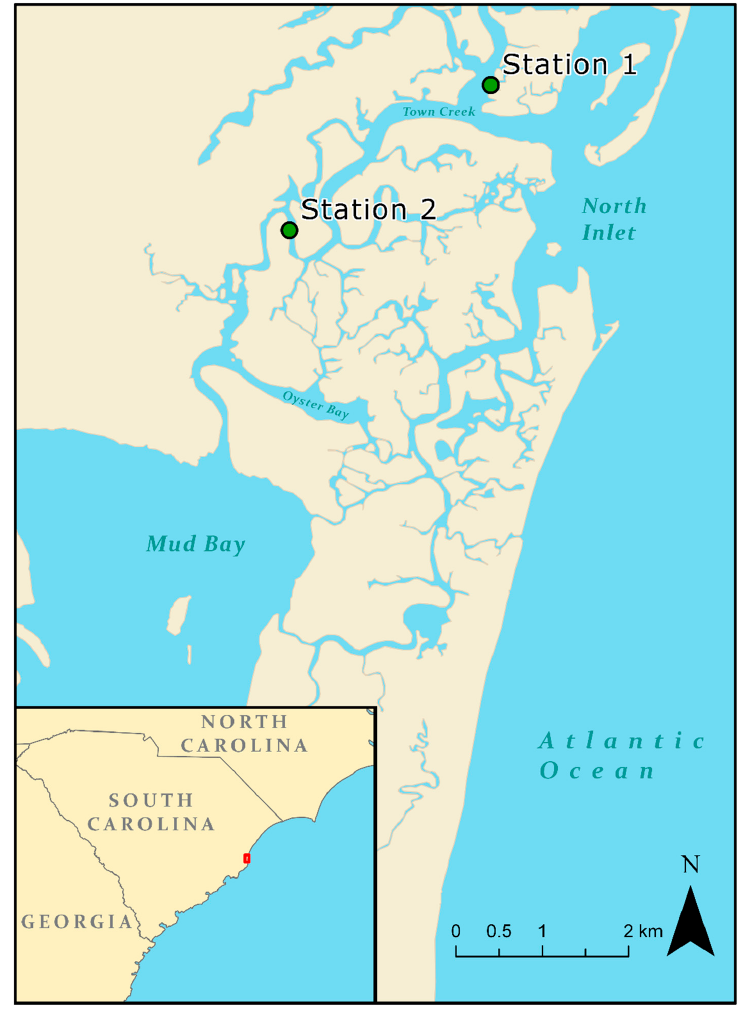
Figure 1. Study site in North Inlet Estuary, South Carolina, USA, showing regional coastline and deployment locations labeled Station 1 and Station 2. Station 1 is located closer to the inlet entrance near the confluence of Town Creek and Old Man Creek. Station 2 is located in the marsh interior, where the channel narrows. Station 1 is situated on a low relieve oyster bank and Station 2 is situated on a steeper mud bank. Both stations are backed by saltmarsh populated with the cordgrass Spartina alterniflora . The base of the marsh scarp coincides with the line delineating the S. alterniflora and the